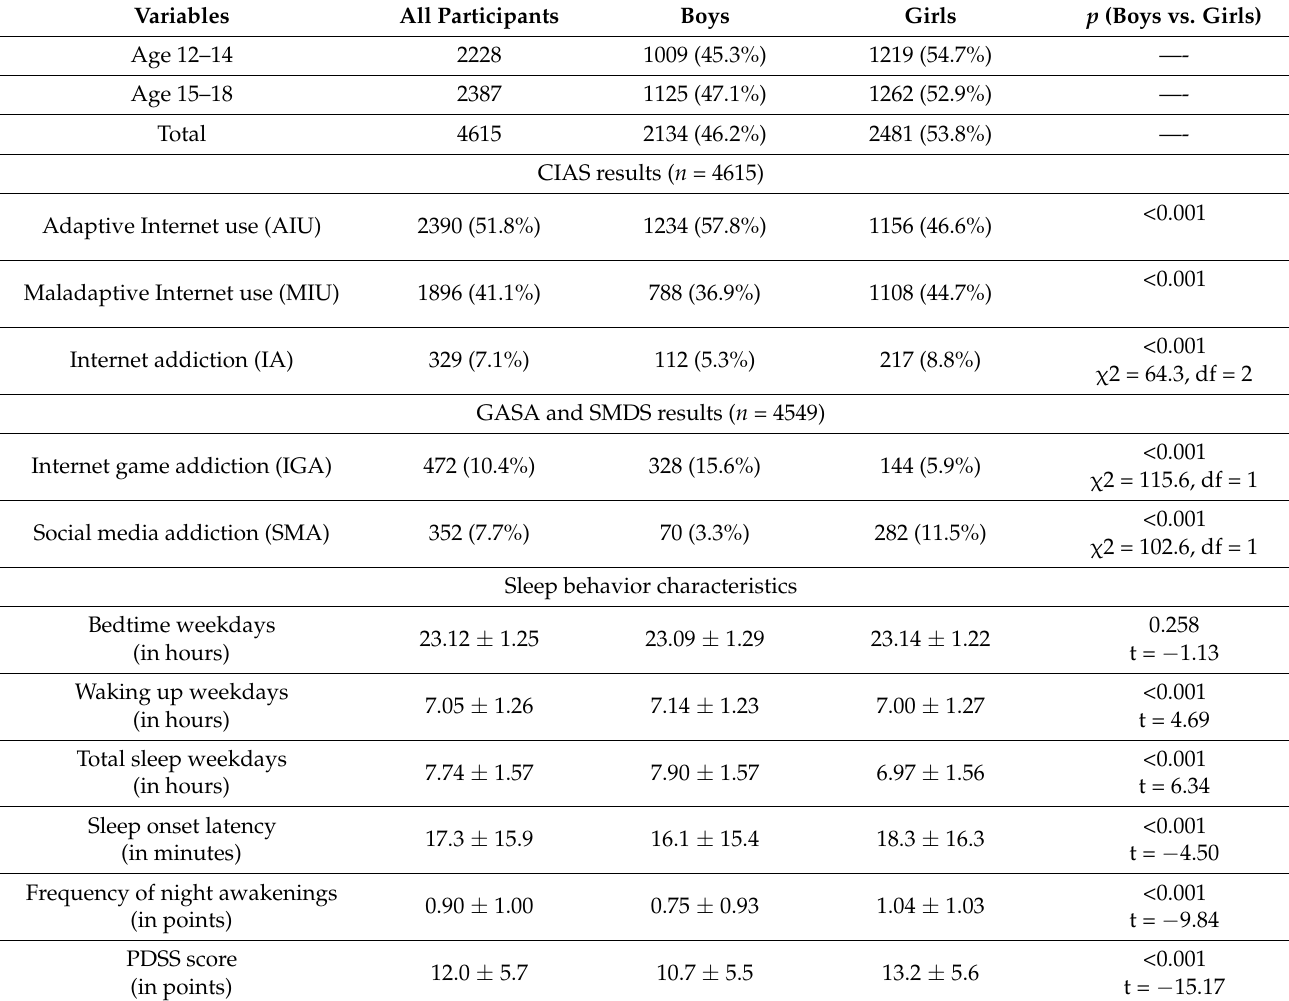
Table 1. Descriptive statistics for major study variables.